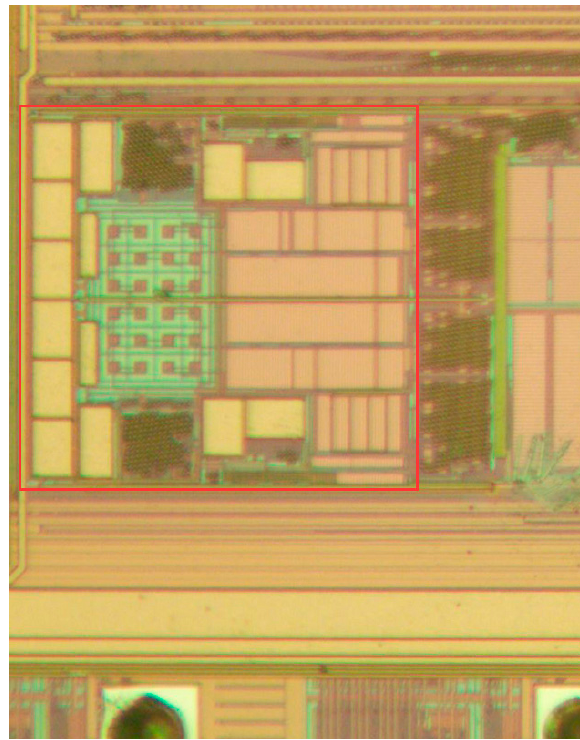
Figure 7. Simulation results of proposed SPWBGR.